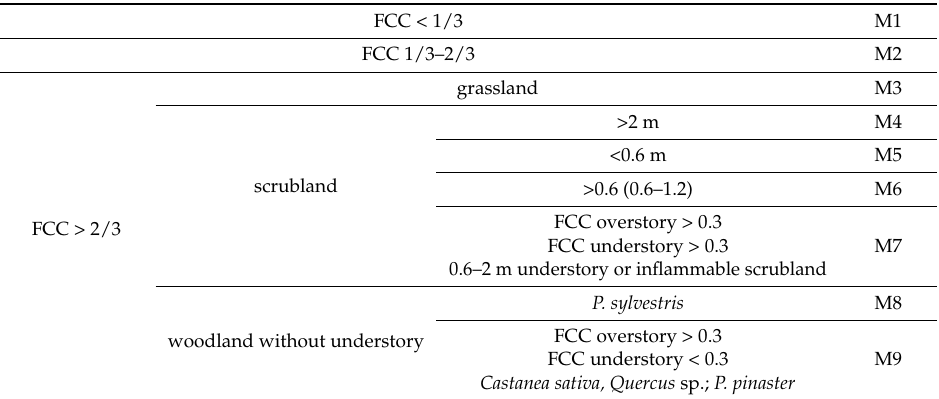
Table 5. Decision tree for the classification of fuel